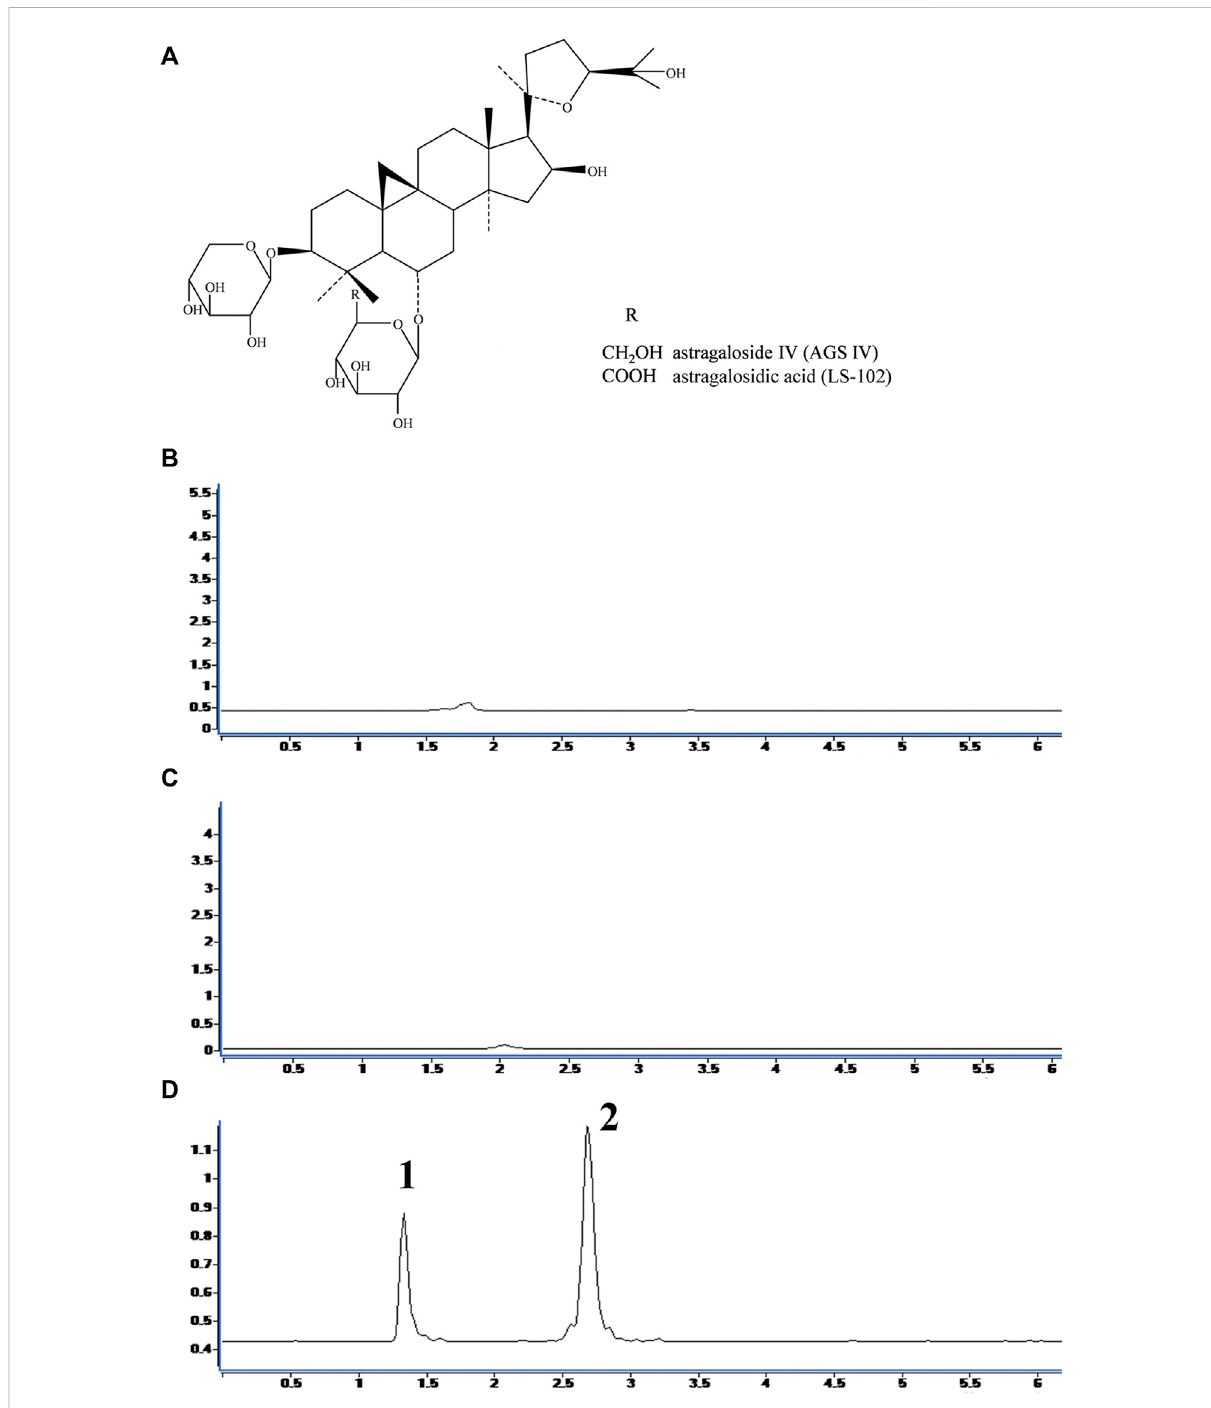
FIGURE 1 (A) Chemical structuresof astragaloside IV(AGS IV) andastragalosidic acid (LS-102). The chromatograms for selectivityvalidation ofLS-102. (B) Blank human plasma; (C) Blank external dialysate; (D) Human plasma (internal dialysate) sample from the protein binding assay; (E) Blank plasma spikedwithLS-102andinternalstandard; (F) Externaldialysatesamplefromtheproteinbindingassay; (G) BlankexternaldialysatespikedwithLS-102 and internal standard; 1, Digoxin; 2,